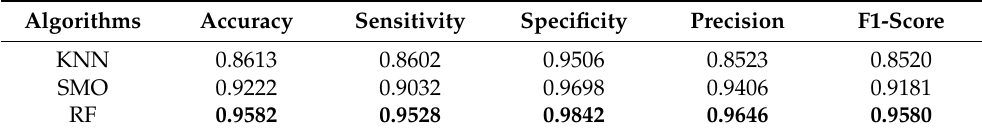
Table 6. Performance metrics result aiming at the four activity intensity labels among these three machine learning